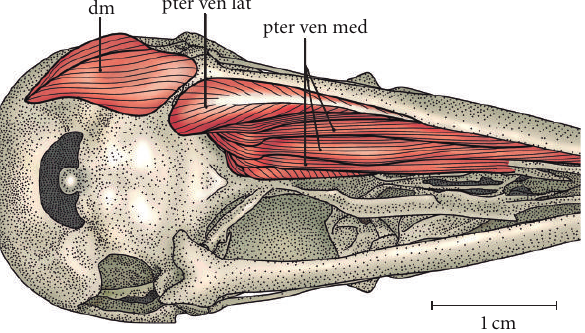
Figure 10: A ventral superficial view of the jaw muscles of Dinopium ra ffl esii. dm: depressor mandibulae; pter ven lat: pterygoideus ventralis lateralis; pter ven med: pterygoideus ventralis